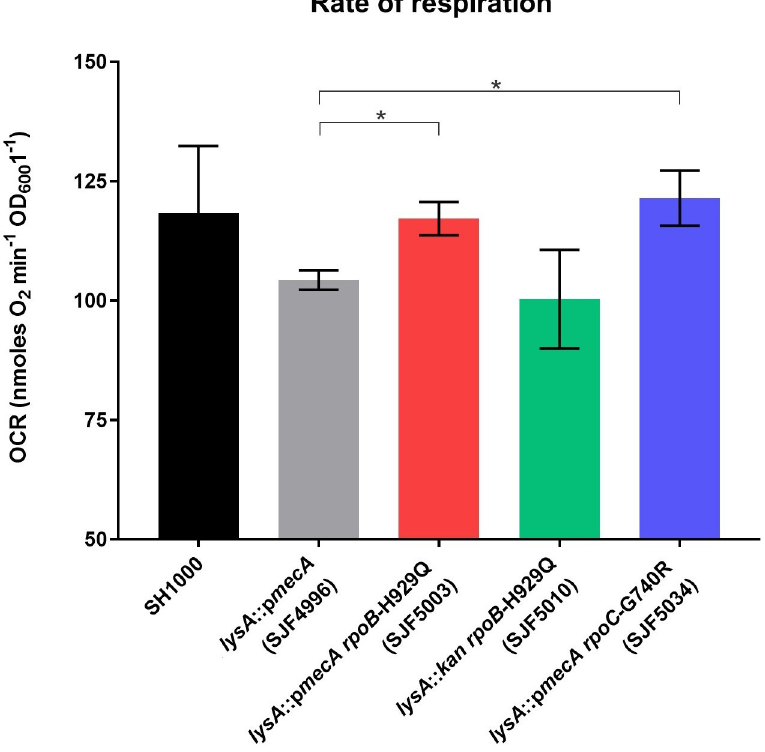
Fig 8. Oxygen consumption rates of S . aureus strains. Cellular respiration was measured for SH1000, lysA ::p mecA (SJF4996), lysA ::p mecA rpoB -H929Q (SJF5003), lysA :: kan rpoB -H929Q (SJF5010) and lysA ::p mecA rpoC -G740R (SJF5034) strains using Clark-type oxygen electrode. Data shown here reflect mean ± SEM of the three biological replicates. The data were compared and analysed against WT and lysA ::p mecA (SJF4996) using unpaired t-test. � p <